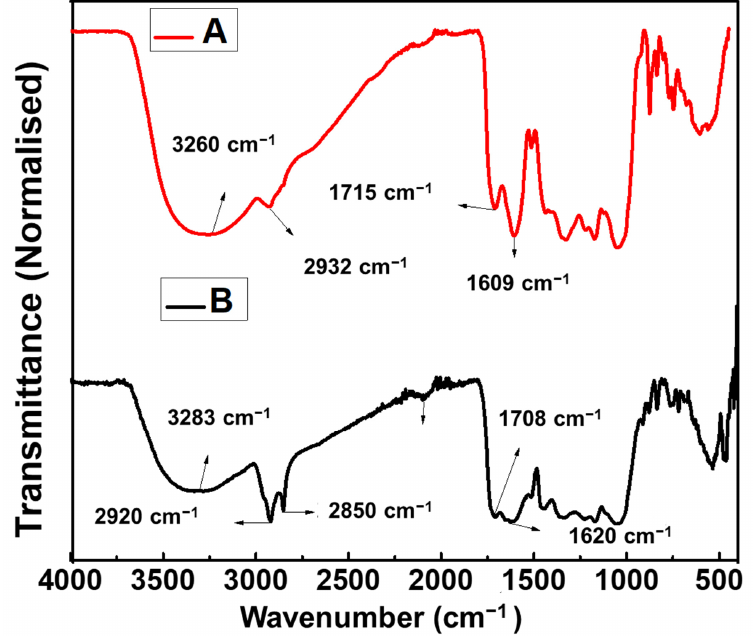
Figure 5. FTIR spectra of ( A ) CE extract, ( B ) PtNPs synthesized from CE extract. Table 1. Assignment of IR bands for CE extract and as-synthesized PtNPs. S.N.